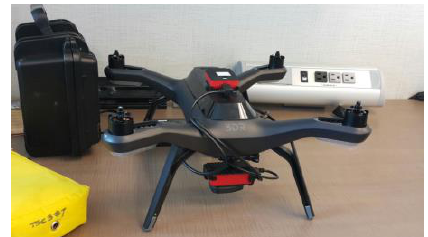
Figure 7. 3DR Solo UAV equipped with the Sequoia Imagery Sensor.